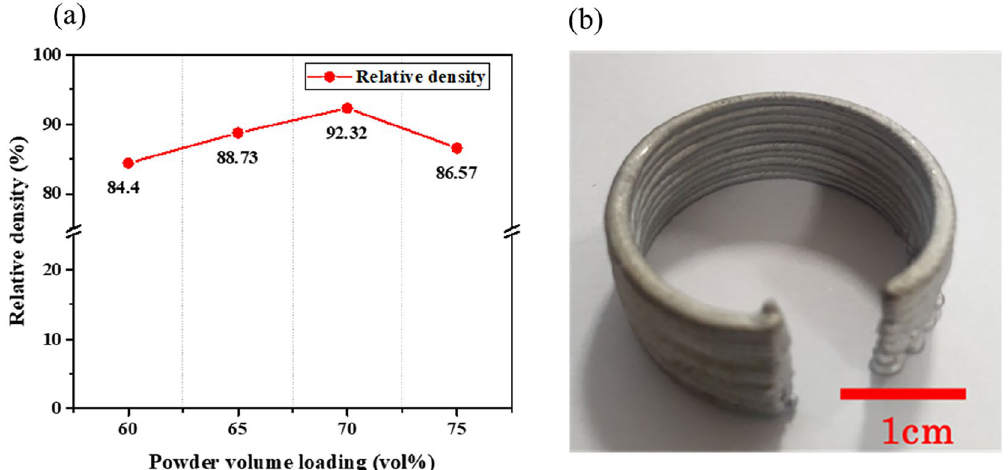
Figure 9. ( a ) Relative density of sintered specimens as a function of powder loading and ( b ) photograph of the sintered 75 vol.%